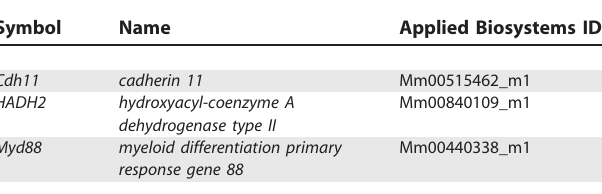
Table 2. Names of Taqman-Based qRT-PCR